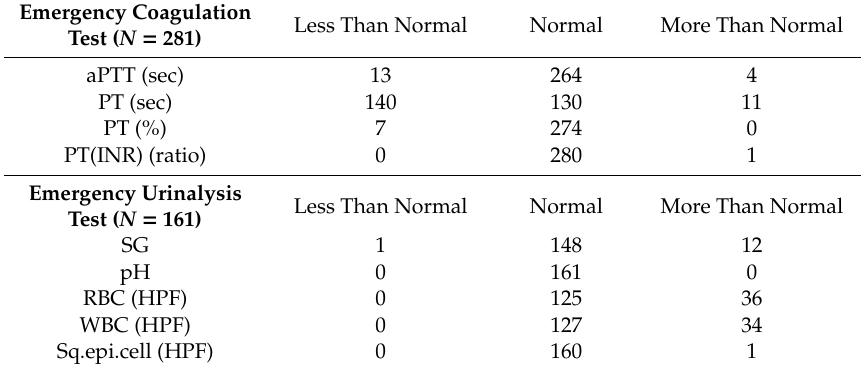
Table 5. Characteristics of the emergency coagulation and urinalysis